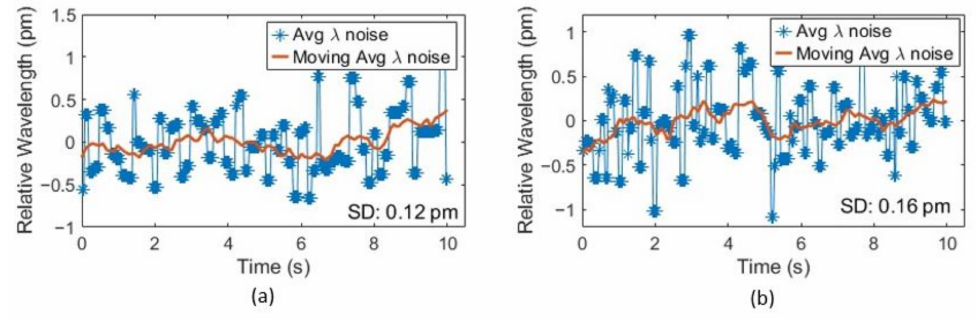
Figure 6. Sensor wavelength resolution at room temperature for pressure of ( a ) 0 psi g and ( b ) 100 psi g .